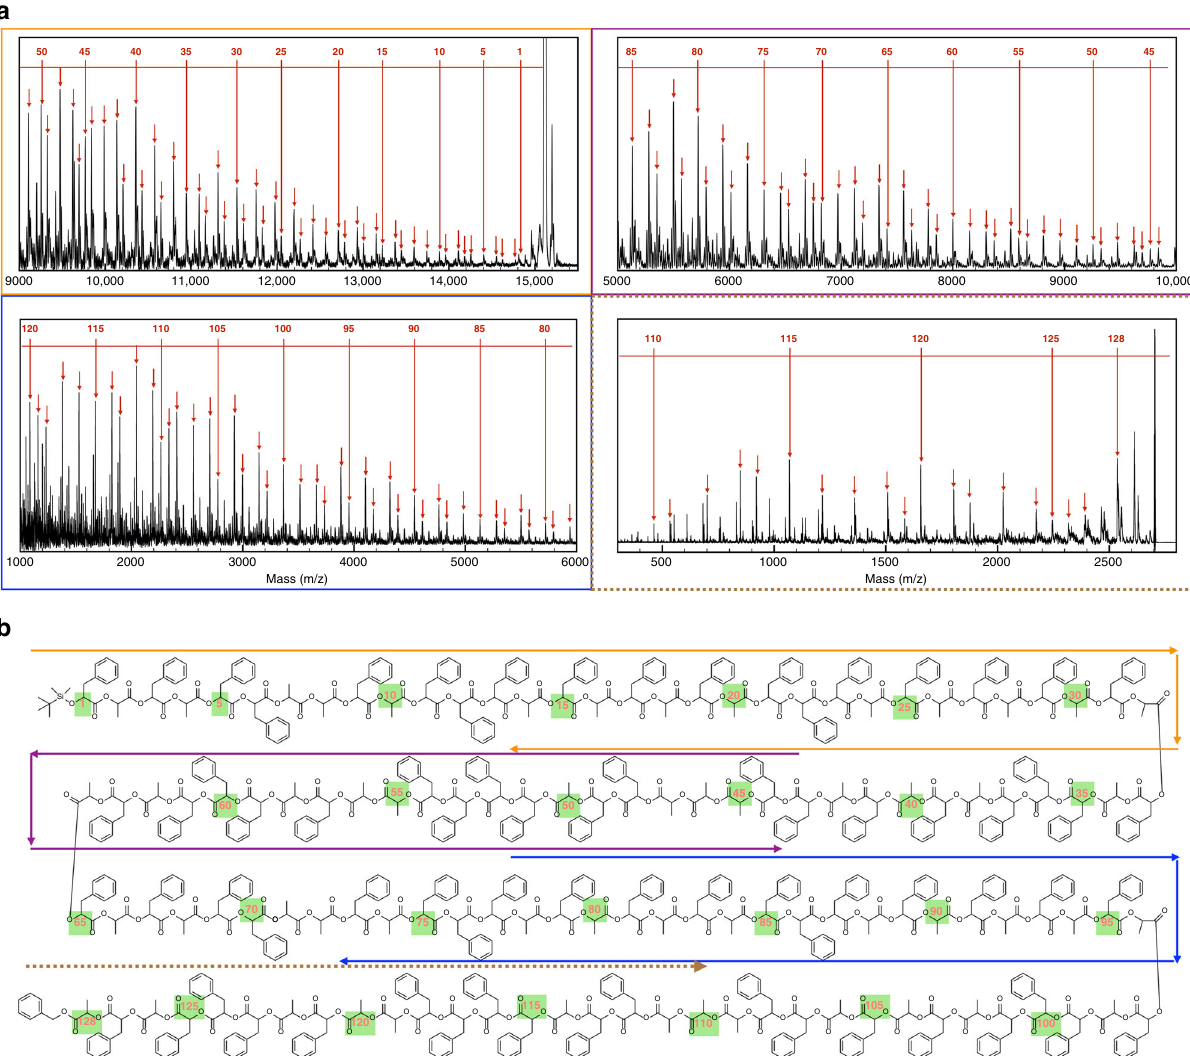
Fig. 4 MALDI-TOF mass sequencing of 128-bit PcL. a A series of MALDI-TOF mass spectra of chemically degraded PcL via hydrolysis. The assigned peaks are marked by arrows. The mass spectra of x i fragments were used for MALDI-TOF sequencing. The sequence of the last 8 repeating units at the Bz terminus was decoded by MALDI-TOF MS/MS to avoid the noise from the signal of the matrix molecules. b The chemical structure of 128-bit PcL drawn with the decoded sequence. The repeating units are numbered in an increasing order from the fi rst repeating unit (P) at the TBDMS terminus. The decoded sequence is identical to the encoded chemical